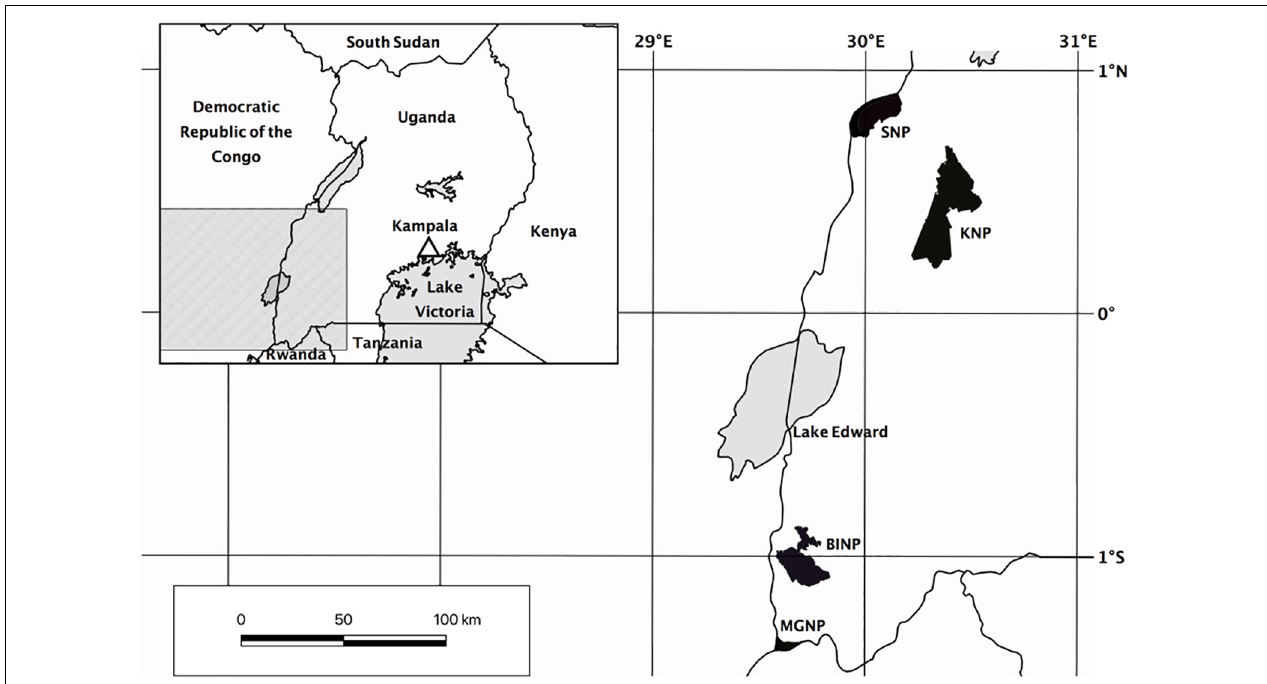
FIGURE 1 | Map of study sites in Uganda. KNP, Kibale National Park; SNP, Semliki National Park; BINP, Bwindi Impenetrable National Park; MGNP, Mgahinga Gorilla National